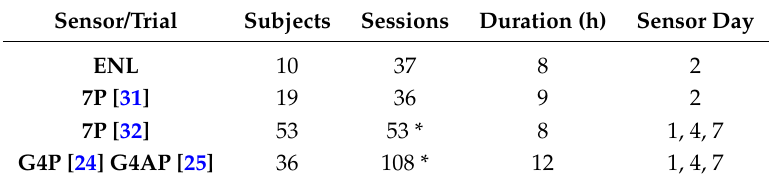
Table 7. The total amount of subjects, in-clinic sessions, duration of each session, and number of days after sensor insertion for the datasets compared of the second generation Medtronic Paradigm Veo Enlite (ENL) sensor and the Dexcom SEVEN PLUS (7P), G4 PLATINUM (G4P), and advanced G4 for artificial pancreas studies (G4AP) sensors.